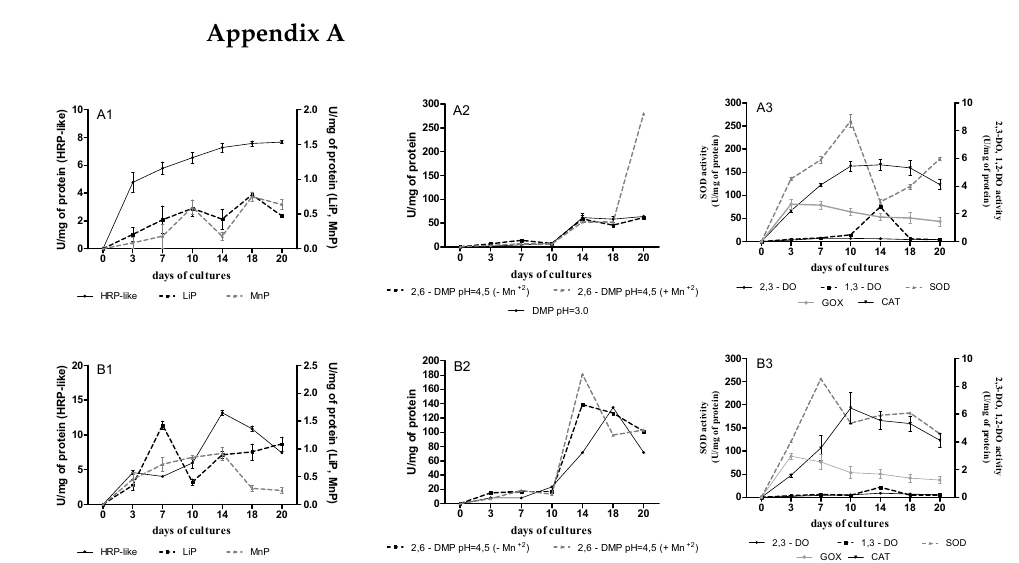
Figure A1. Activities of oxidoreductases (U/mg) in cultures of B. adusta CCBAS 930 supplemented with daunomycin (DNR) ( A1 – A3 ) and doxorubicin (DOX) ( B1 – B3 ) (1,2-DO (1,2-dioxygenase), 2,3-DO-(2,3-dioxygenase), CAT (catalase), GOX (glucose oxidase), HRP-like (horsheradish-type peroxidase), LiP (lignin peroxidase), MnP (manganese-dependent peroxidase), PhC (phenolic compounds), SOD (superoxide dismutase), SOR (superoxide radical levels), VP (versatile peroxidases activity measurement without Mn +2 in pH = 3.0 and pH = 4.5 and with Mn+2 in pH = 4.5).